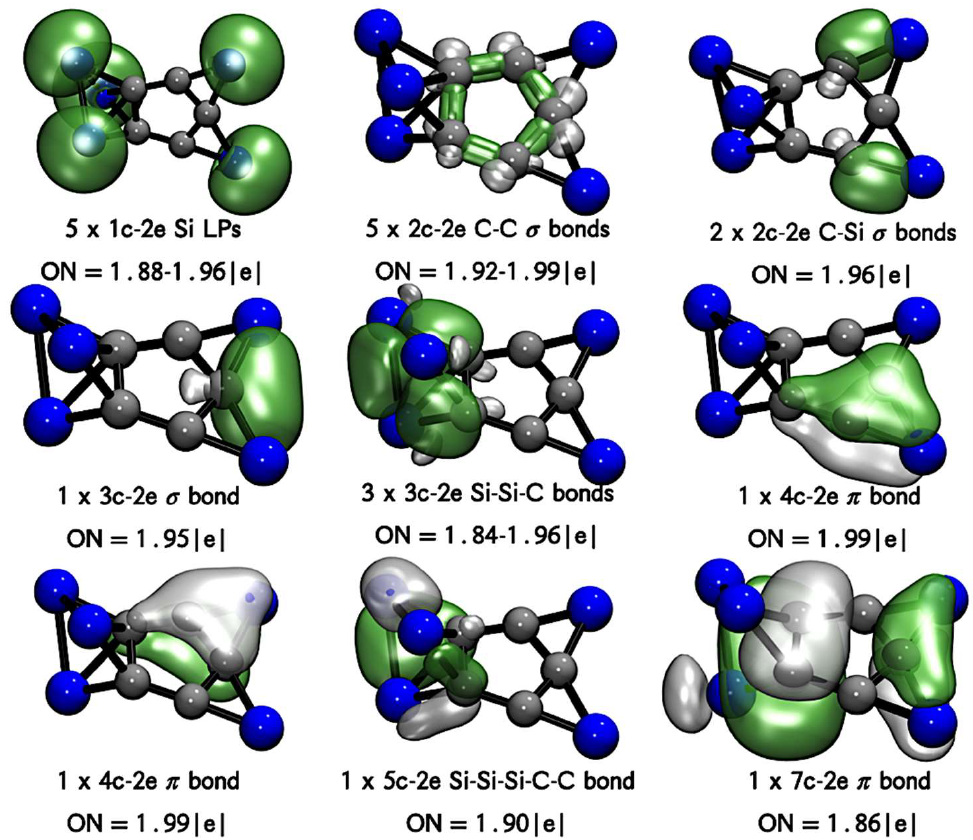
Figure 3. AdNDP bonding pattern of cluster Si 5 C 5 . Occupation numbers (ONs) are shown.